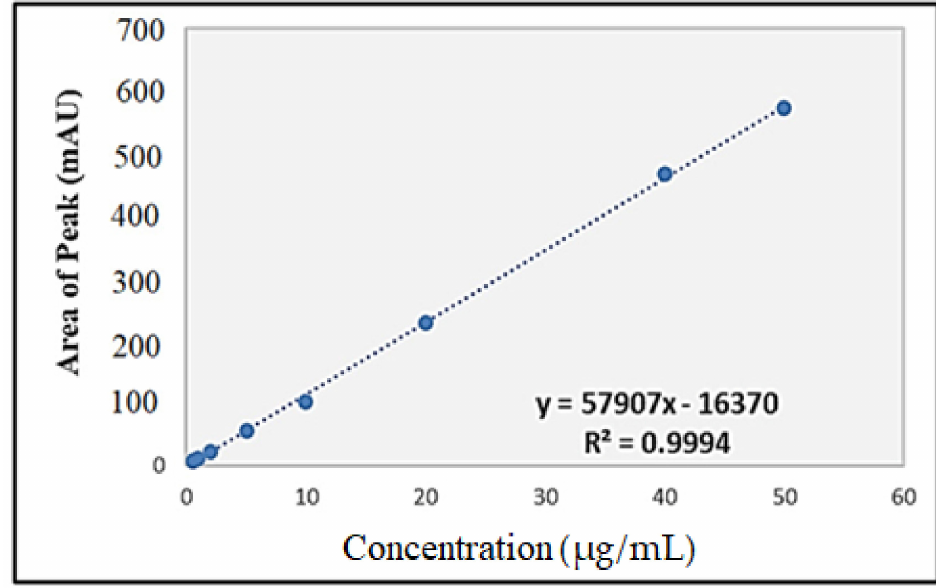
Figure 4. Standard curve of ibuprofen for HPLC